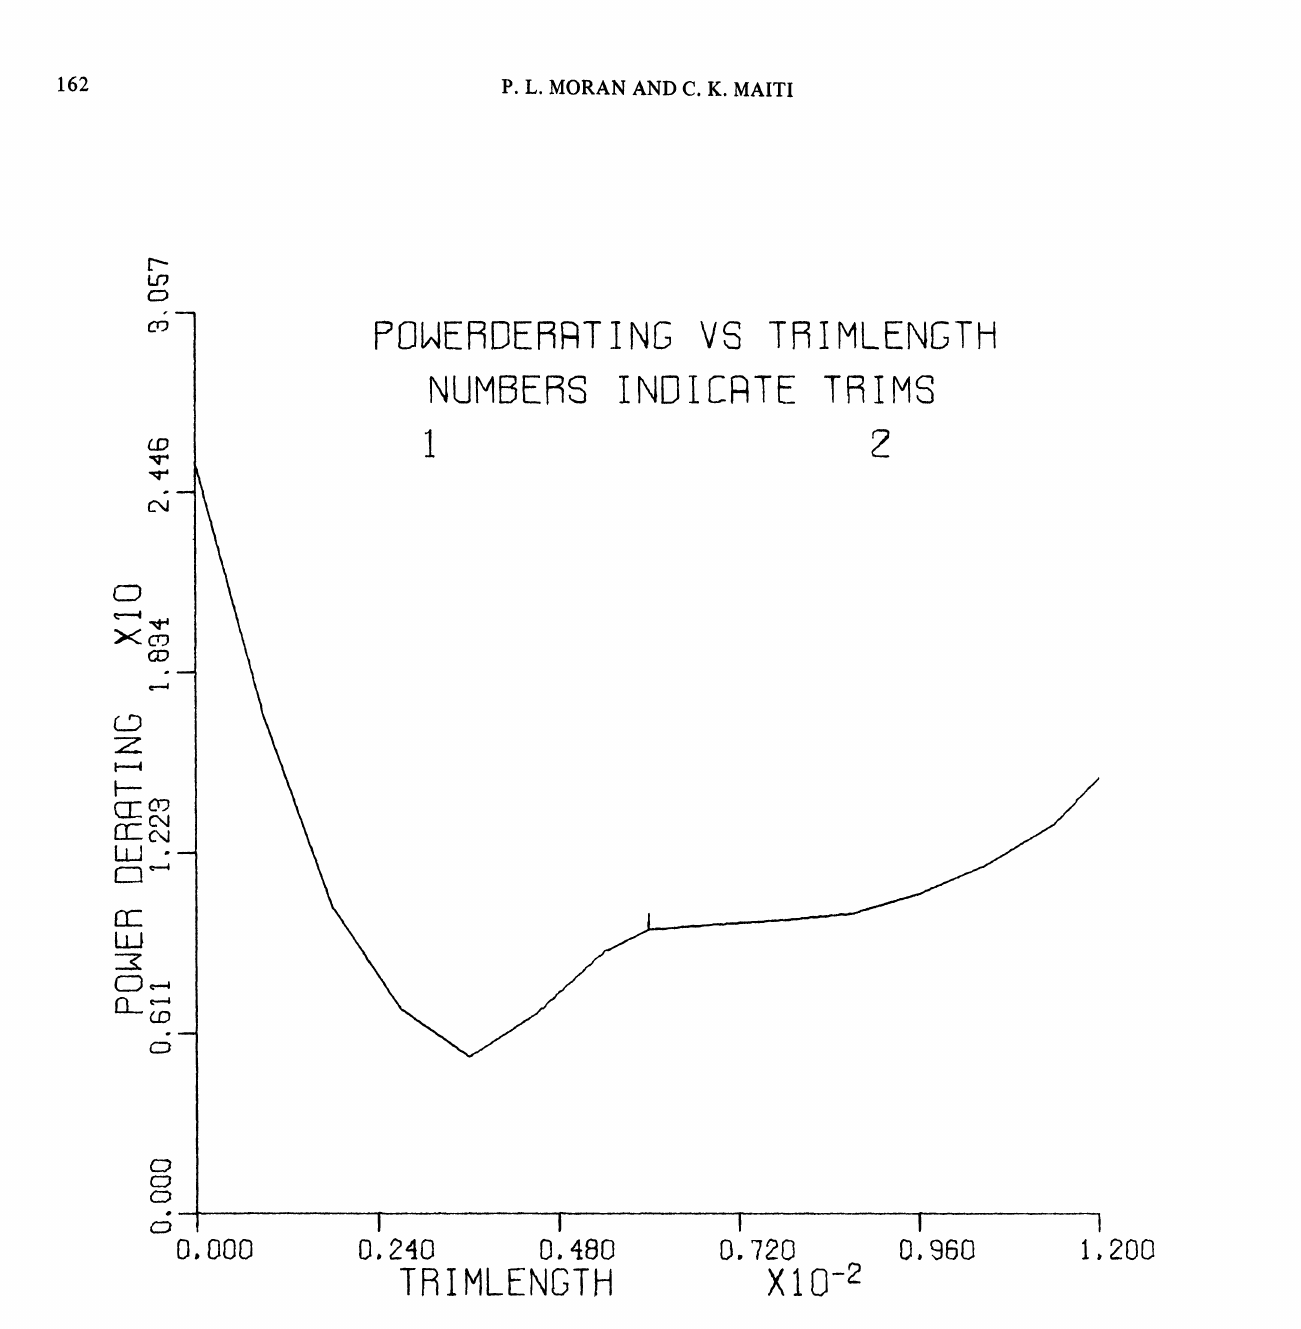
FIGURE 6 Graphical output (e) Power derating vs.